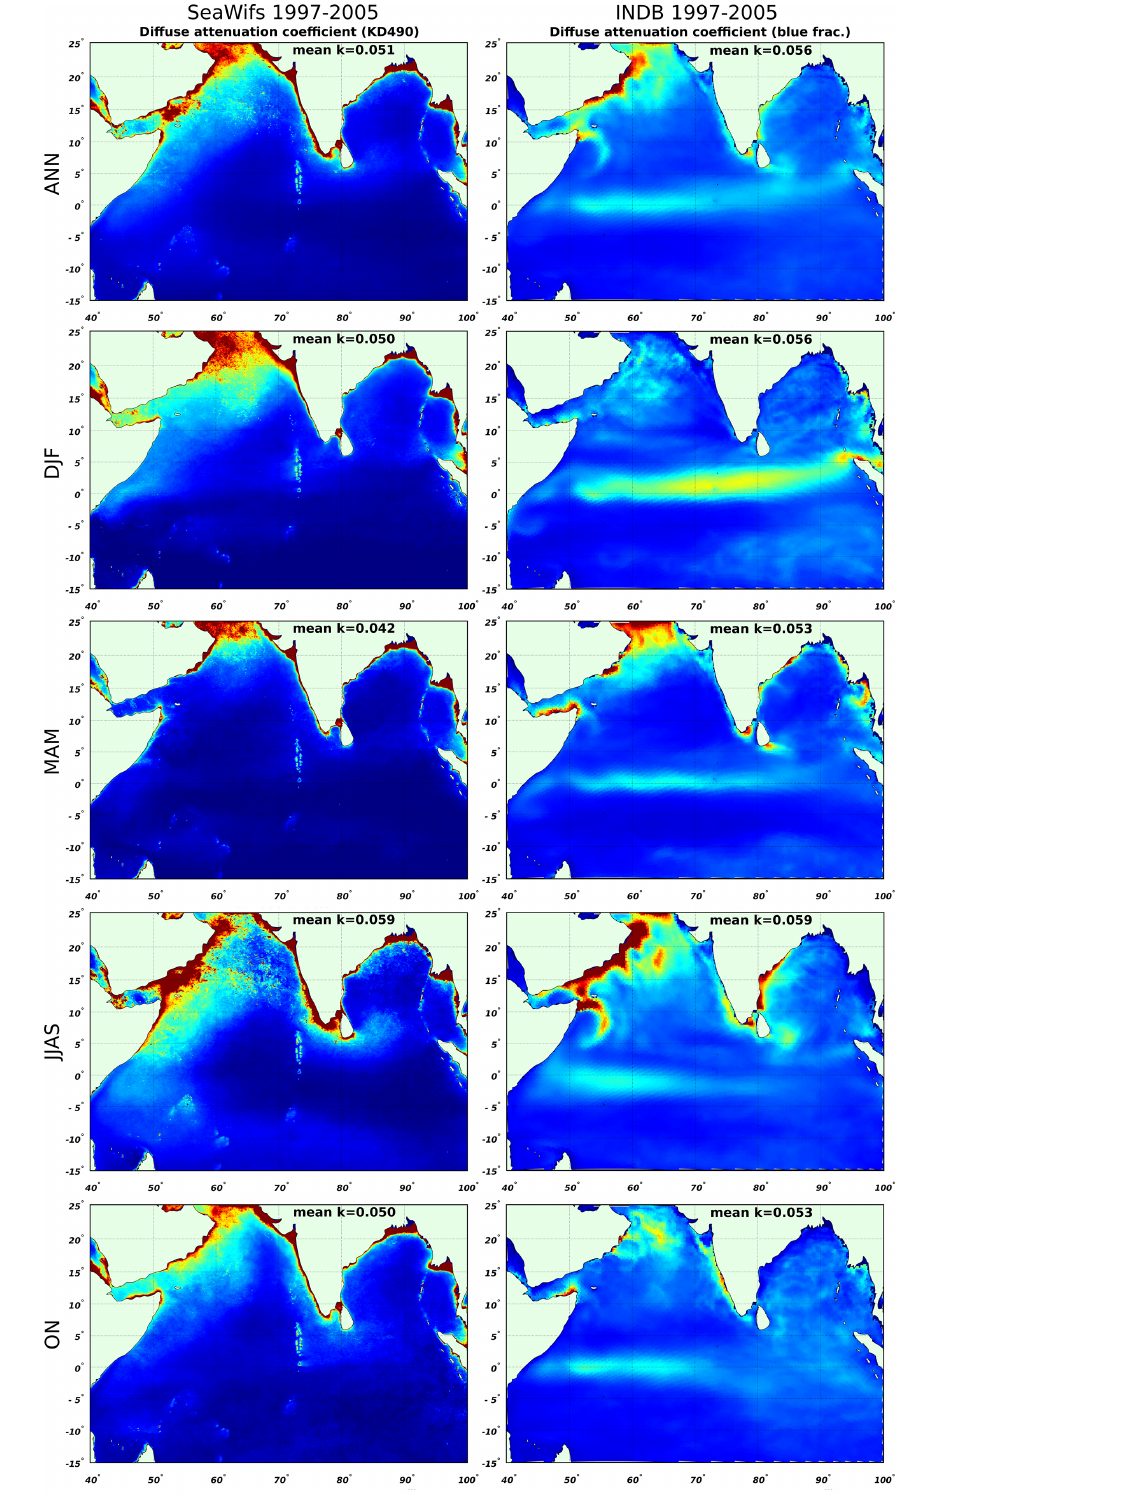
Figure 16. Spatial distribution of the attenuation coefficient at the ocean surface averaged annually (ANN) and seasonally (DJF, MAM, JJAS, ON). Left column – SeaWiFS data (NASA Goddard Space Flight Center, 2021c) averaged over 1997–2005; right column – INDB results averaged over 1997–2005. For all figures, a mean value of the attenuation coefficient (inside the domain) is presented.